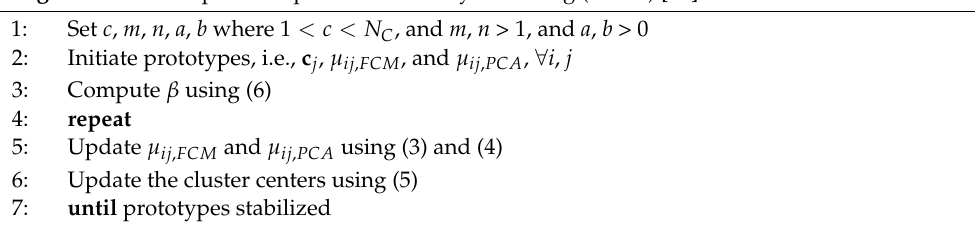
Algorithm 1. Unsupervised possibilistic fuzzy clustering (UPFC) [28].